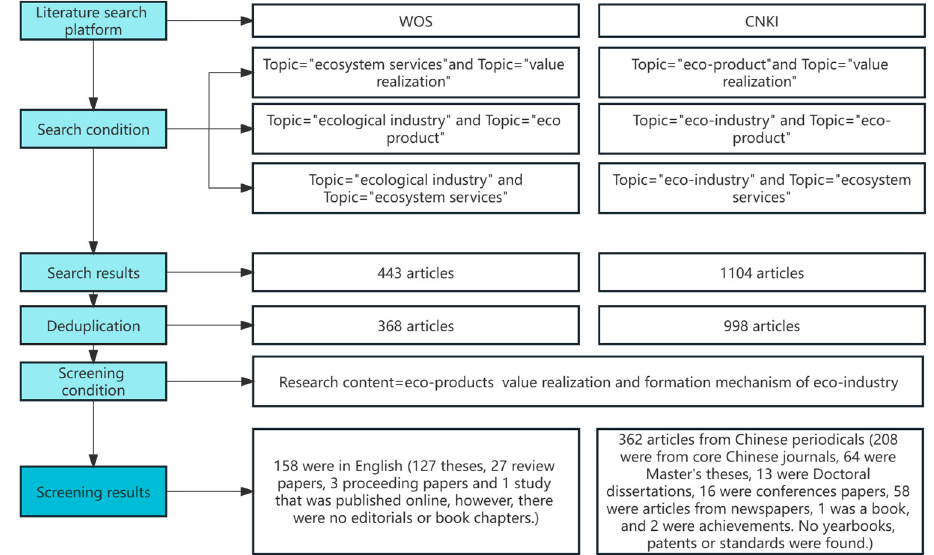
Figure 1. The research process illustrated from the initial search to the thorough screening using the study’s systematic mapping process (identification, screening, qualification, and inclusion). Database searches were used to find documents during the identification stage. Then, the papers that had been selected underwent the screening and eligibility phases for ecosystem service supply, value accounting, value realization, and eco-industry (by title, keywords, abstract, and full text articles). Ultimately, the study included articles that satisfied the eligibility requirements.